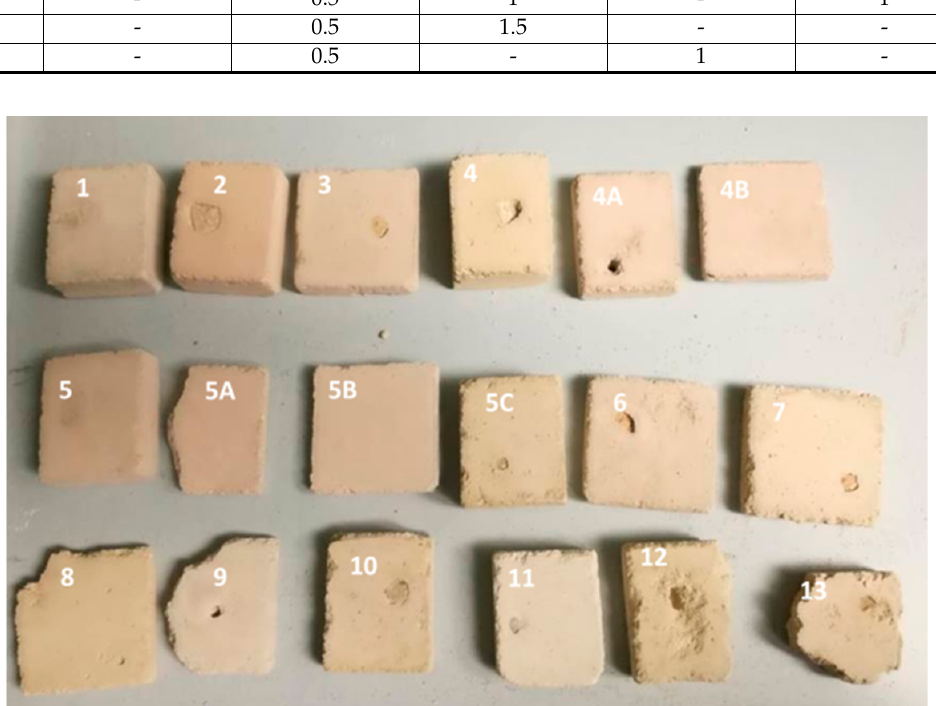
Figure 2. Photo of the laboratory-prepared MM samples after artificial ageing, Table 1. Mix design for preparation of model mortars (volume ratio).